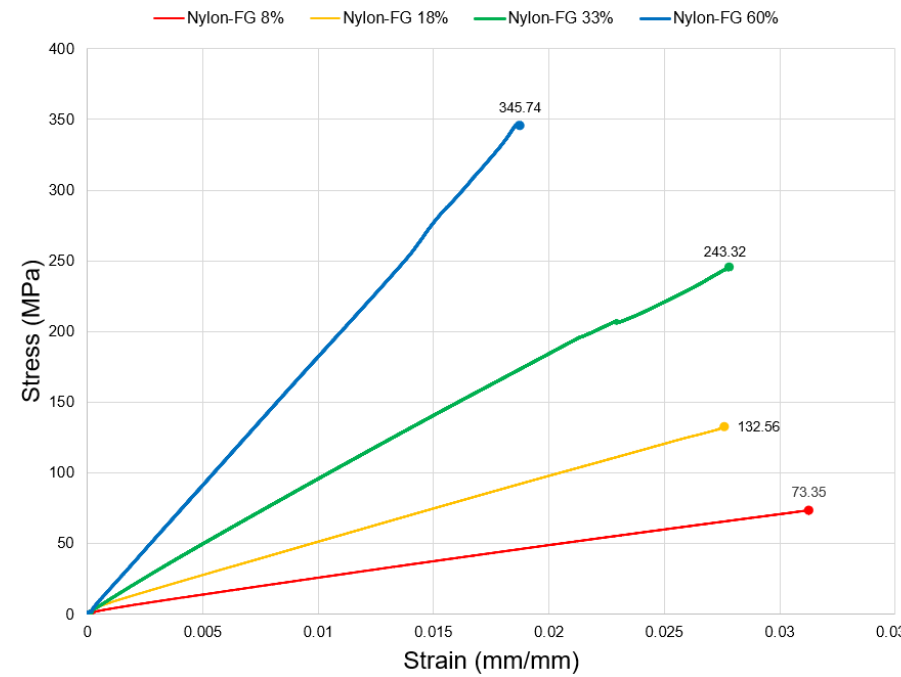
Figure 7. Effect of FG volume fraction on tensile strength of CFRAM nylon-FG.